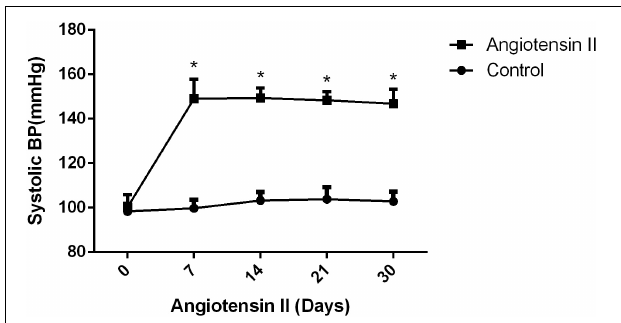
FIGURE 1 | Effect of angiotensin II on systolic blood pressure (SBP) in middle-aged mice. The systolic blood pressure of the middle-aged mice was measured 7, 14, 21, and 30 days after the infusion of saline or angiotensin II ( n = 7 per group). Data are expressed as the means ± SD. * p <